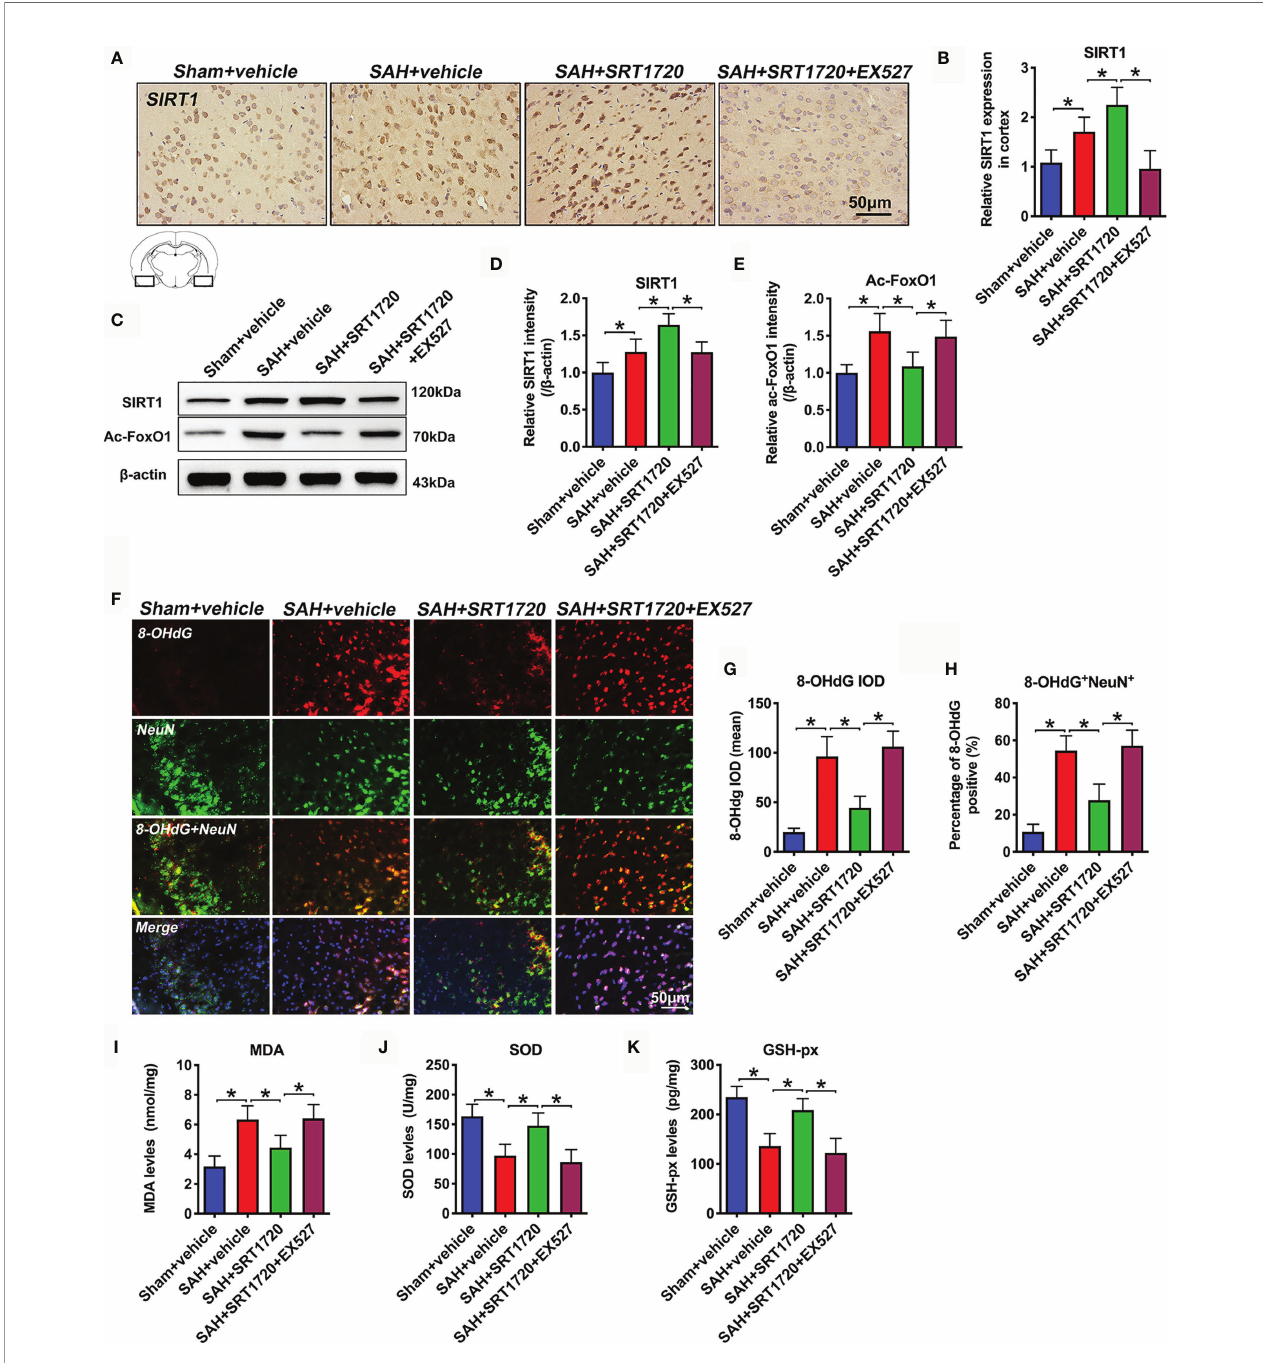
FIGURE 3 | Effects of SRT1720 on SIRT1 activation and oxidative damage after SAH. Representative photomicrographs (A) and quanti fi cation of SIRT1 immunohistochemistry staining (B) . Representative western blots (C) and quanti fi cation of expressions of SIRT1 (D) and ac-FoxO1 (E) in all groups. Representative photomicrographs (F) and quanti fi cation of 8-OHdG immuno fl uorescence staining (G, H) . For histopathology studies, the basal temporal lobe adjacent to the clotted blood was evaluated. Quanti fi cation of MDA (I) , SOD (J) , and GSH-px (K) expressions in all groups. Bars represent the mean ± SD. * P <